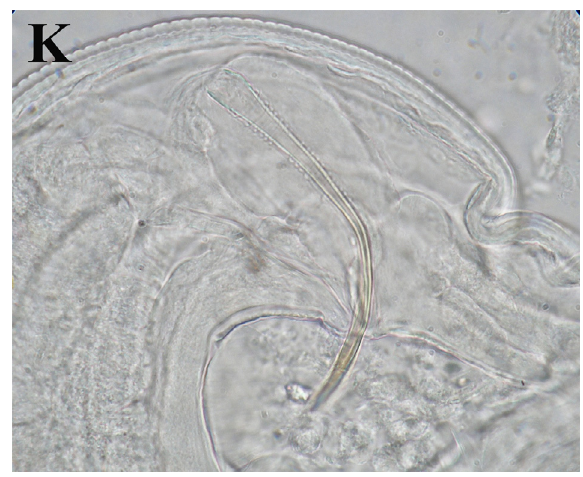
Figure 3. (K) Pterygodermatites ( Paucipectines ) baiomydis n. sp., a parasite of Baiomys taylori from Colima, Mexico. K. Left spicule surrounded by folded spicular